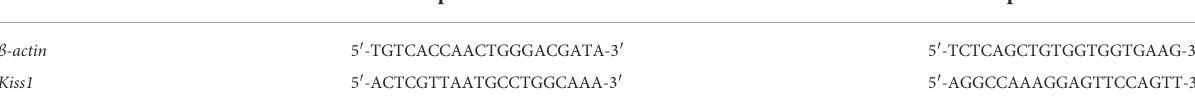
TABLE 1 RT-PCR primer pair sequences. Gene